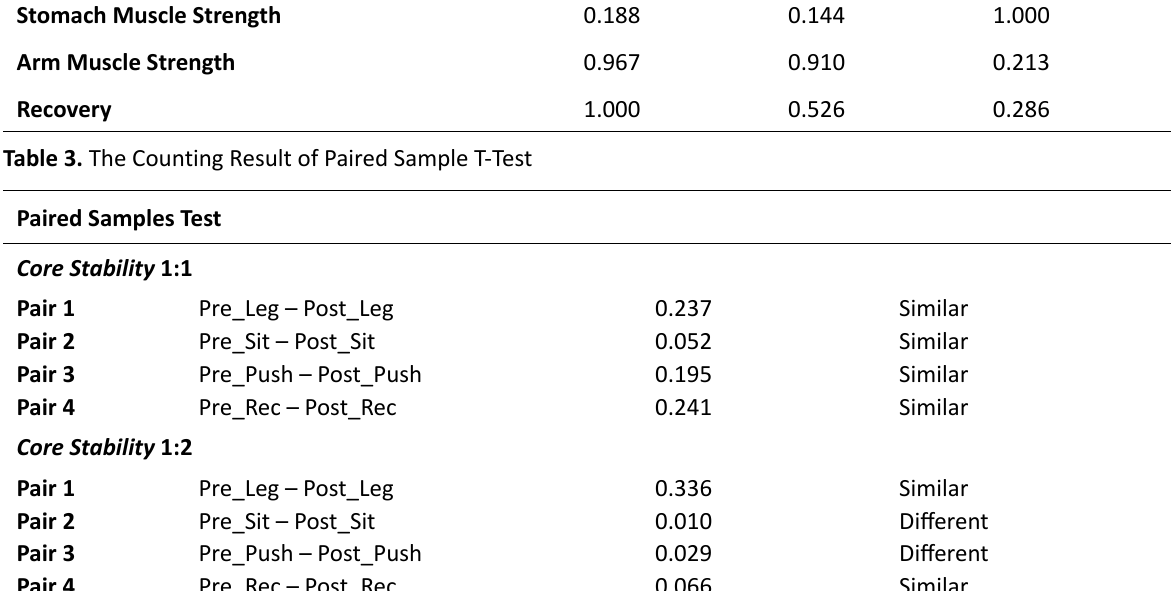
Table 4. The Result of Independent Sample T-Test of 1:1 and 1:2 interval exercise Independent Samples